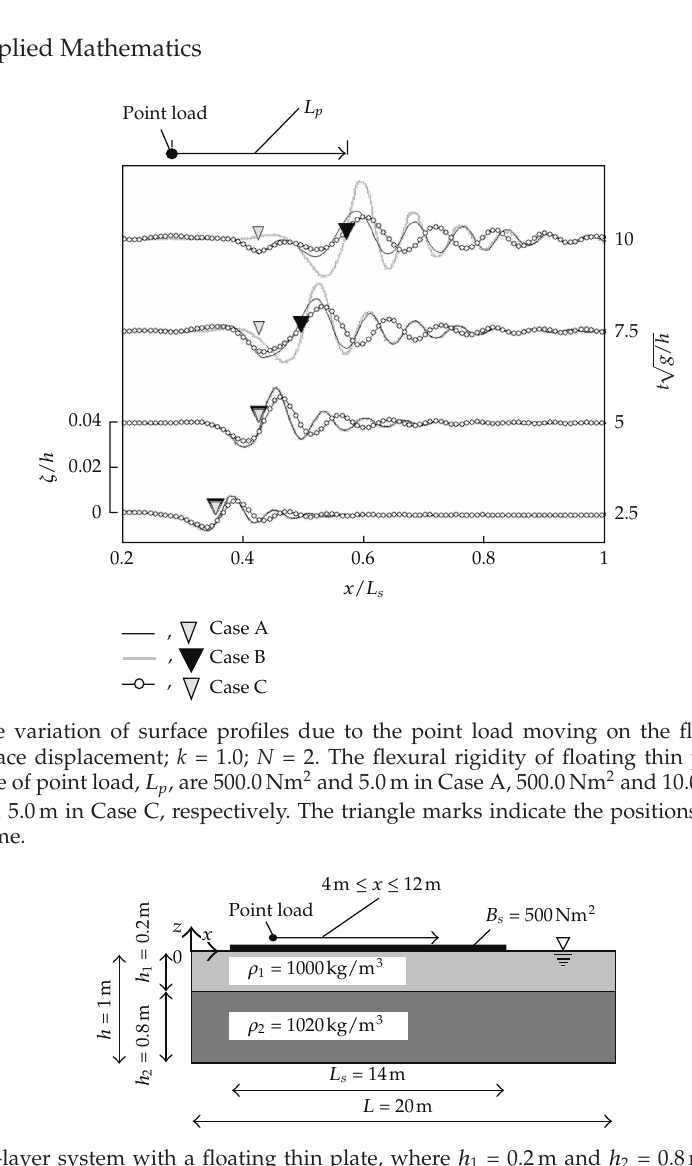
Figure 12: Two-layer system with a floating thin plate, where h 1 (cid:7) 0.2m and h 2 (cid:7) 0.8m. The thin plate, whose length L s is equal to 14.0m, covers the water surface from x (cid:7) 1.0m to 15.0m. The flexural rigidity of thin plate, B s , is equal to 500.0Nm 2 . The point load moves on a one-way path between x (cid:7) 4.0m and 12.0m at a constant